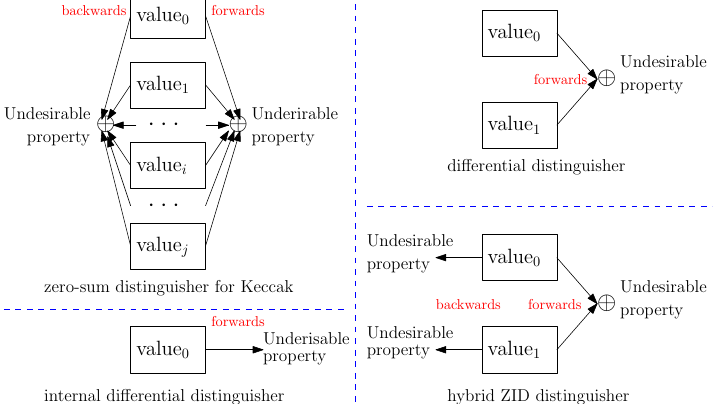
Figure 4: Illustration of the